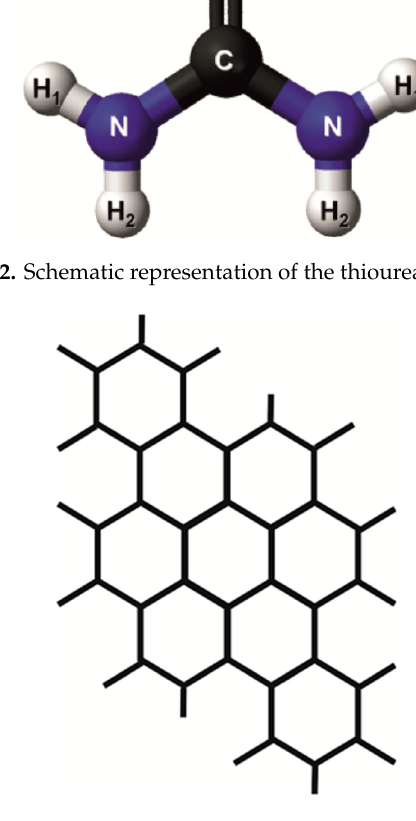
Figure 3. Plane schematic representation of rhombohedral thiourea structure. Nine complete tunnels with a distance of 9.2 Å between their centres are shown.